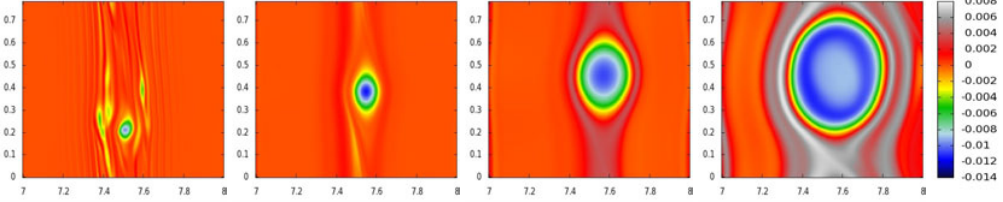
Figure 5. Vorticity map for a disk with thermal di ff usion after 20, 200, 500 and 1600 rotations, from left to right, respectively. The formed vortex becomes a hollow vortex.